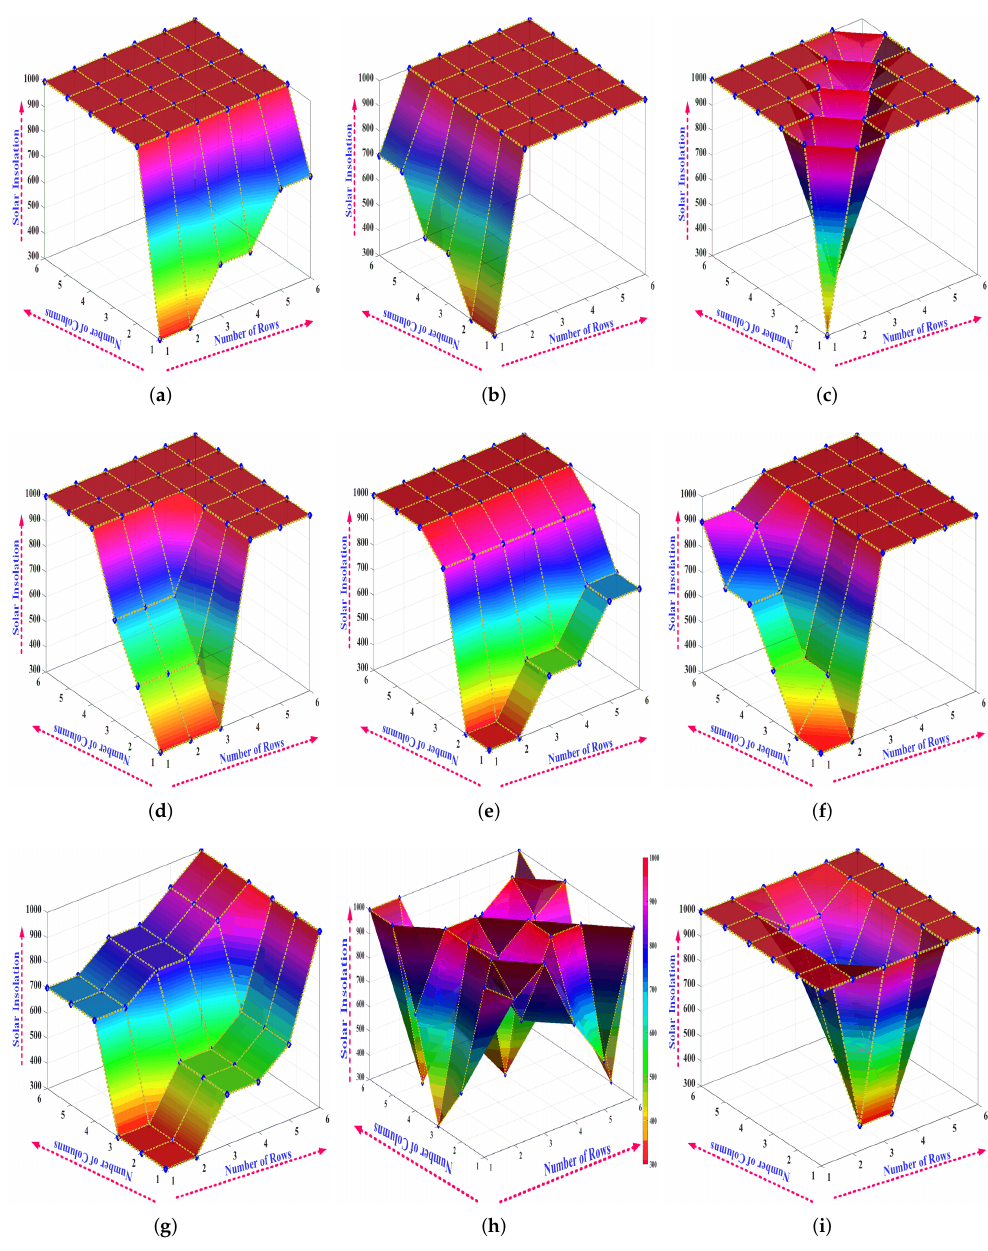
Figure 4. Representation of various shading patterns and corresponding insolation levels on PV array topologies: ( a ) uneven-row, ( b ) uneven-column, ( c ) diagonal, ( d ) SAN, ( e ) SAW, ( f ) LAN, ( g ) LAW, ( h ) random, and ( i )